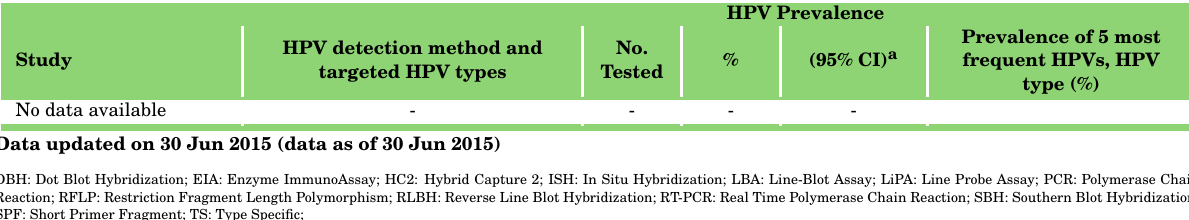
Table 27: Studies on HPV prevalence among vulvar cancer cases in Peru